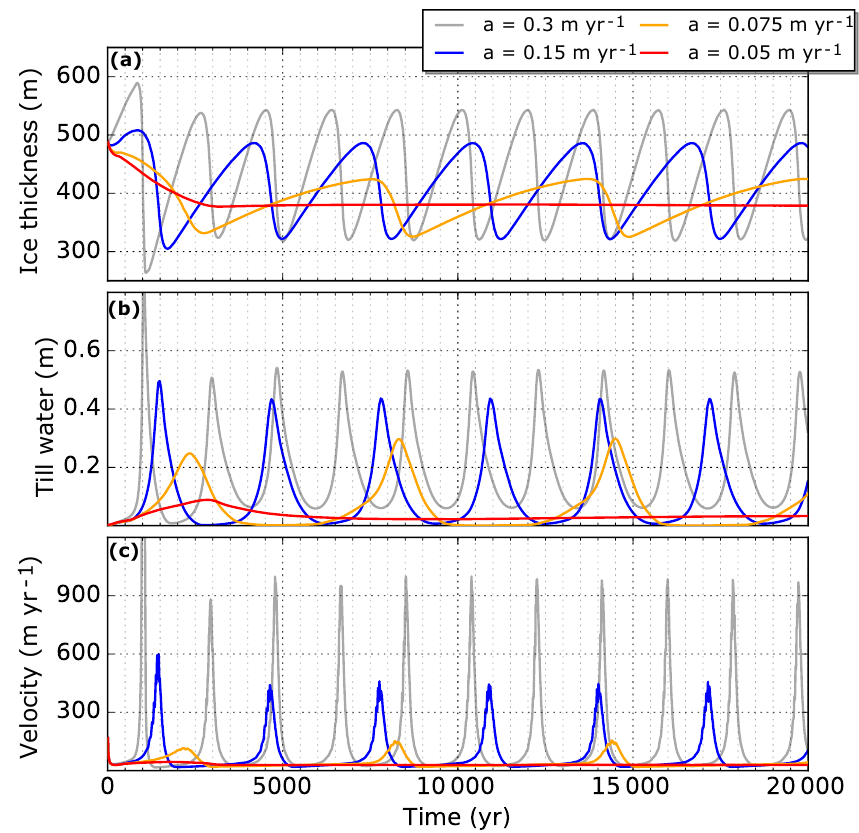
Figure 9. Time series of (a) ice thickness H , (b) till water thickness W till and (c) ice velocity (all averaged over area of grounded ice) for different values of the surface accumulation a . With decreasing a (default case in gray) the surge magnitude decreases and the cycle duration increases such that for sufficiently low accumulation surging is not